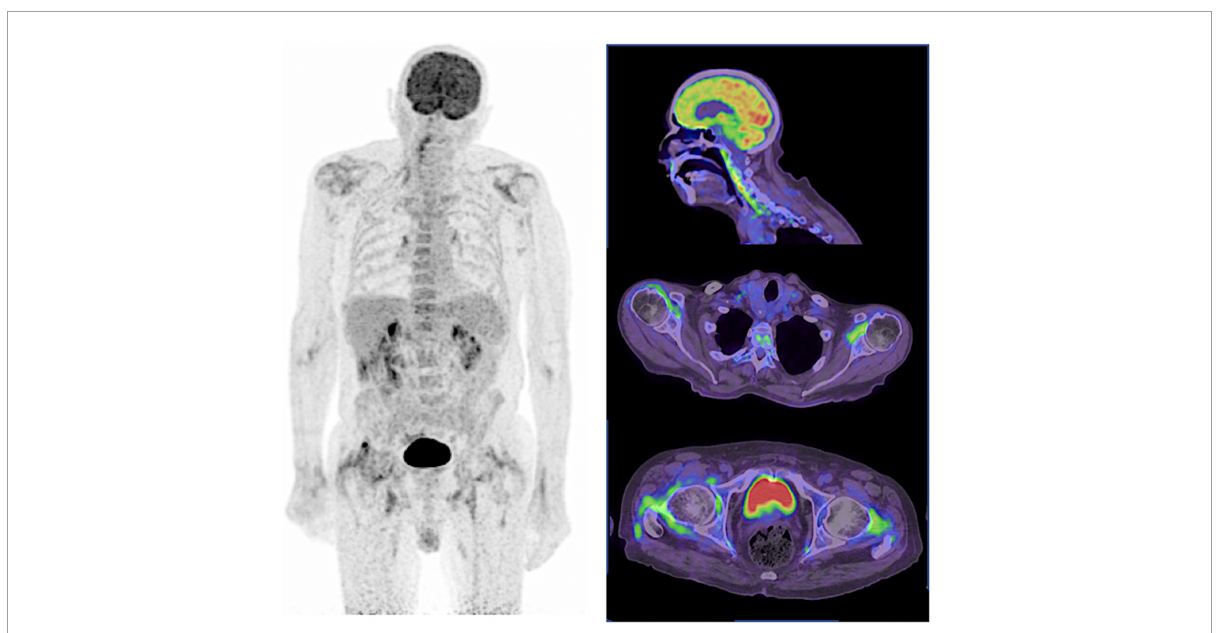
FIGURE3 18 F-FDG PET of PMR. In PMR, active LVV frequently overlaps, as illustrated here with the long linear and smooth 18F-FDG uptake of the right vertebral artery in this corticosteroid resistant PMR patient. As for SpA, 18 F-FDG uptake of the sterno-clavicular joints, scapular, and pelvic girdles is also typically